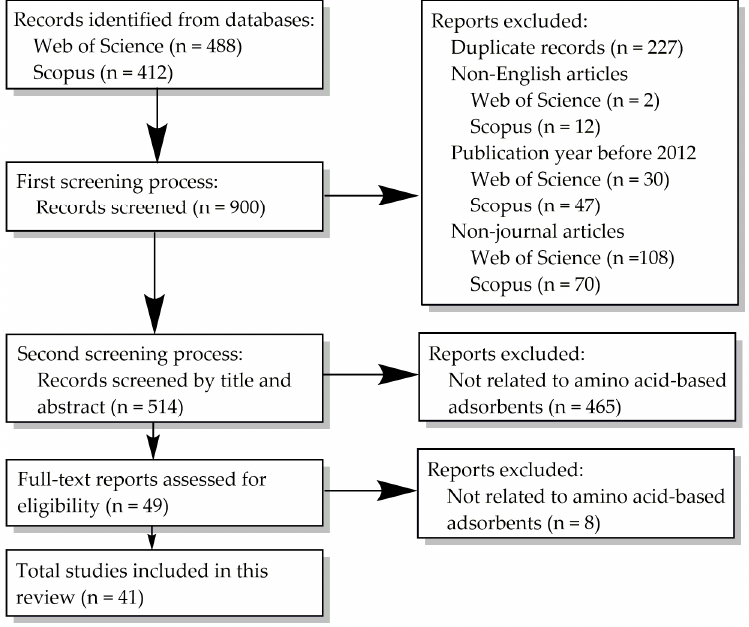
Figure 2. PRISMA flowchart for searching and screening